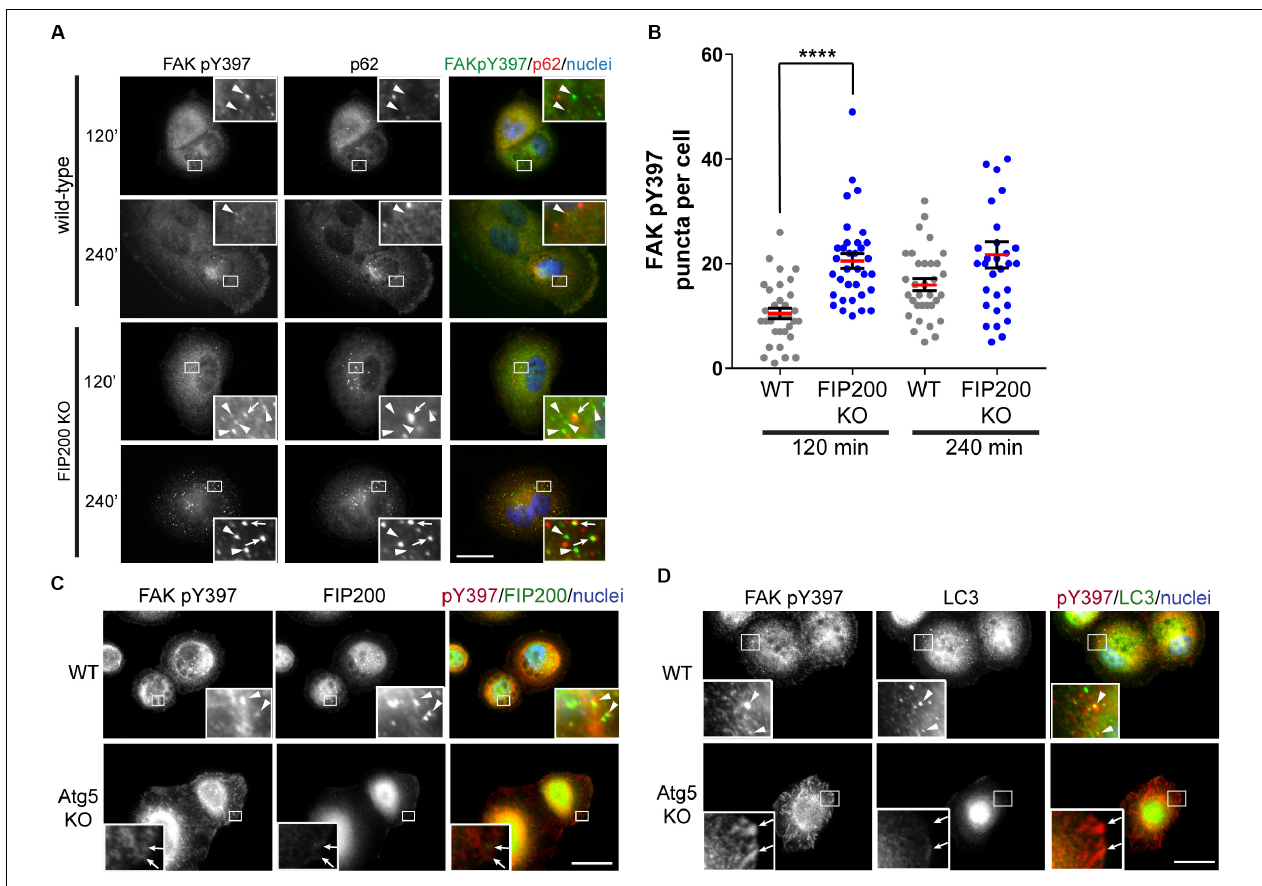
FIGURE 3 | Differential dysregulation of FAK pY397 trafficking in FIP200 and Atg5 KO cells. (A) MCF10A wild-type and FIP200 KO cells were subjected to fibronectin induced cell adhesion and fixed at indicated time points of 120 and 240 minutes post-plating. Immunostaining was performed against FAK pY397 (green) and p62 (red). Nuclei were labeled with Hoechst (blue). Arrowheads indicate FAK pY397 spots and arrows indicate FAK pY397 and p62 colocalization. (B) Quantitation of immunofluorescence images taken from cells subjected to fibronectin induced adhesion. The number of FAK pY397 puncta per cell were quantified from between 30 and 34 cells per group across random fields of view from 2 independent experiments. Each data point indicates a cell, the red bar indicates mean value and error bars represent SEM. **** p < 0.0001. Immunofluorescence microscopy performed on wild-type (WT) and Atg5 KO MCF10A cells following attachment to fibronectin. Cells were fixed at 120 min post-plating and immunostained in (C) for FAK pY397 (red) and FIP200 (green), and in (D) for FAK pY397 (red) and LC3 (green). Nuclei are labeled with Hoechst (blue). Arrowheads indicate areas of colocalization and arrows indicate FA-like immunostaining. Scale bars = 10 µ m.